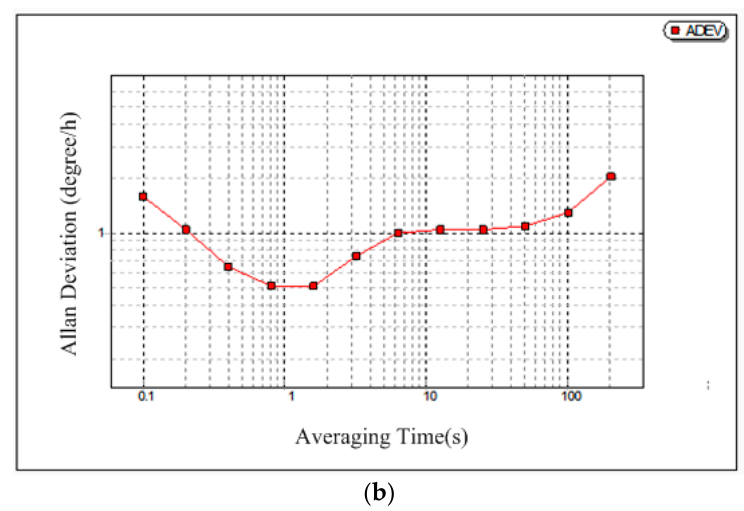
Figure 8. ( a ) Input-output characteristic of the proposed rotational gyroscope; ( b ) Log-log plot of ADEV versus the averaging time for the angular speed of the proposed rotational gyroscope.